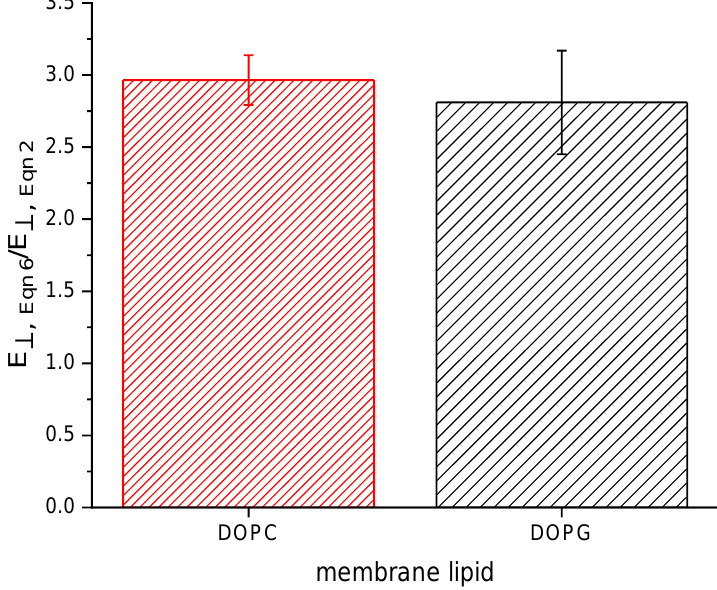
Figure 2. Young’s moduli calculated using Equation (6) are approximately three times larger than those calculated by Equation (2).